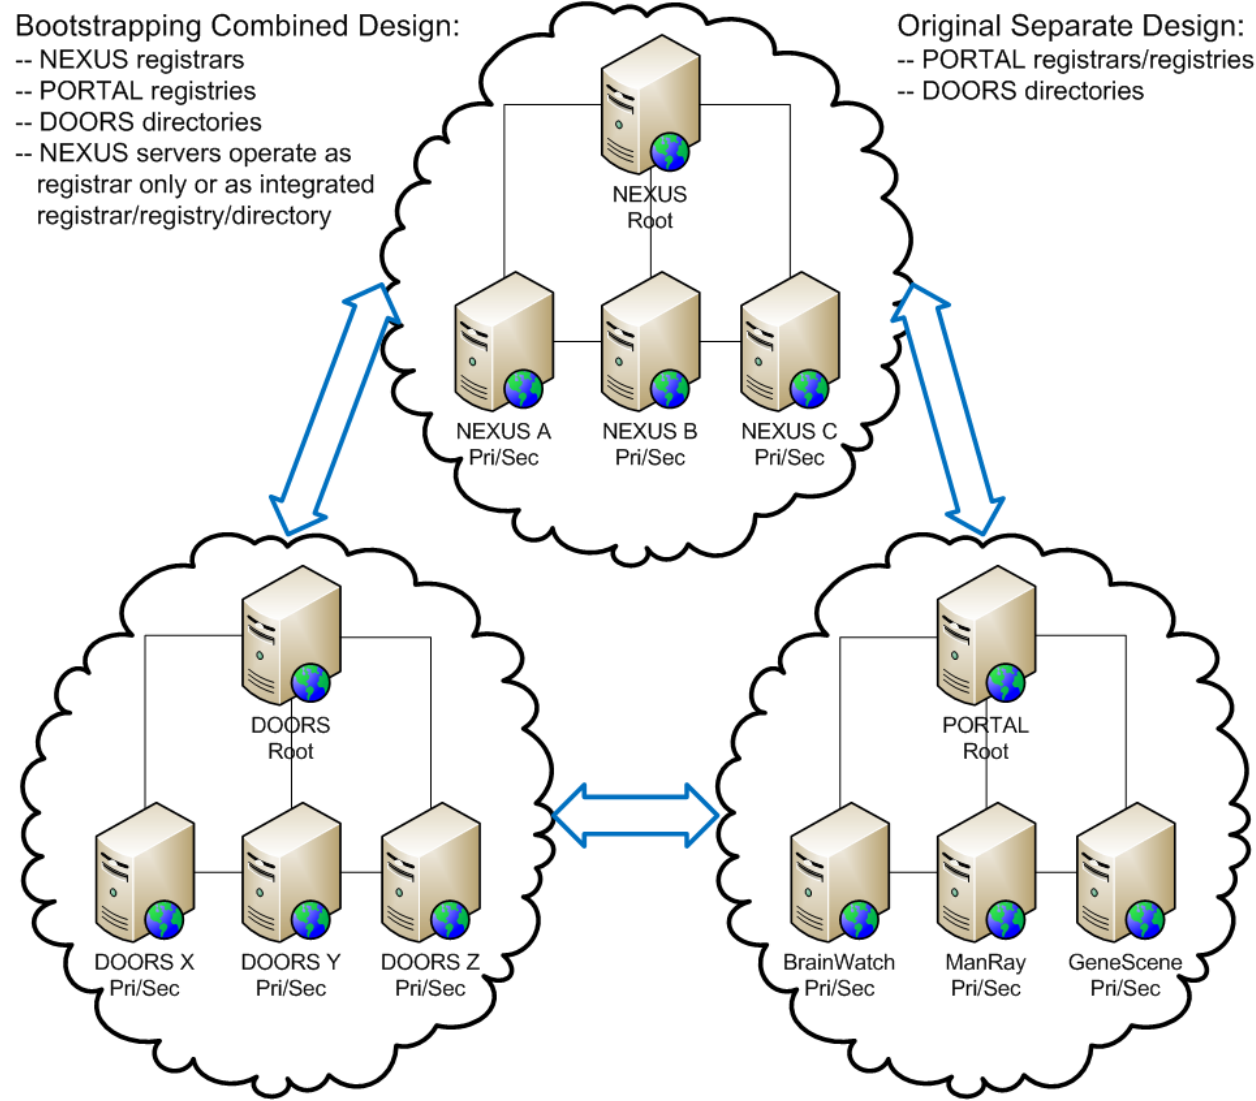
Figure 3. PORTAL-DOORS System Server Network: PDS server networks with interacting clouds of NEXUS registrars, PORTAL registries, and DOORS directories. NEXUS servers may expose either the NEXUS registrar service for the separate design or the integrated set of NEXUS registrar, PORTAL registry, and DOORS directory services for the combined de- sign. These resource metadata server networks for PORTAL registering of labels and tags and DOORS publishing of locations and descriptions are analogous to domain metadata server networks for IRIS registering of names and DNS publishing of addresses. Primary PORTAL registries may be established by an organization or person who maintains any local policies governing registration of resources at that particular primary PORTAL reg- istry. Examples shown here (GeneScene, BrainWatch, ManRay) implement policies with a problem-oriented focus on their respective specialty domains. Specific criteria for registra- tion are determined by the local schema of the PORTAL primary which must nevertheless comply with the global requirements of the PORTAL root in order to assure interoperability between different PORTAL